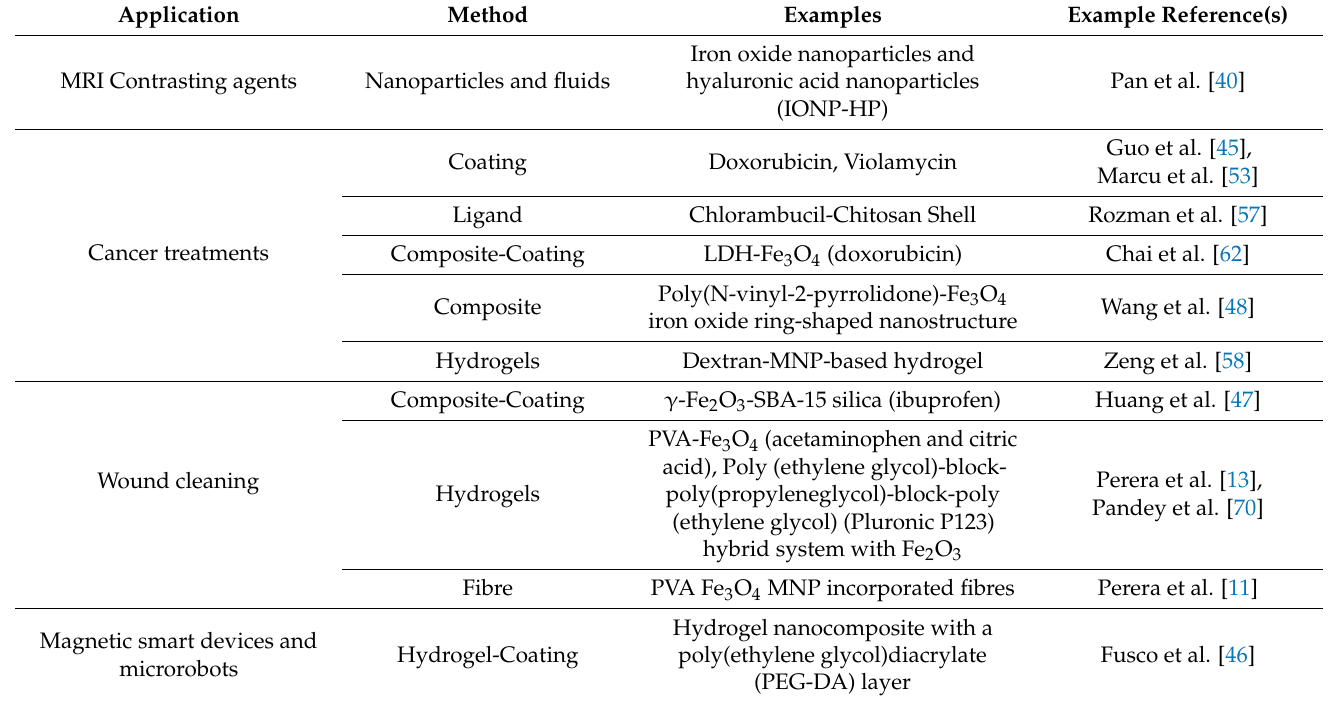
Table 1. Summary of applications, methods of incorporation and examples of iron based magnetic